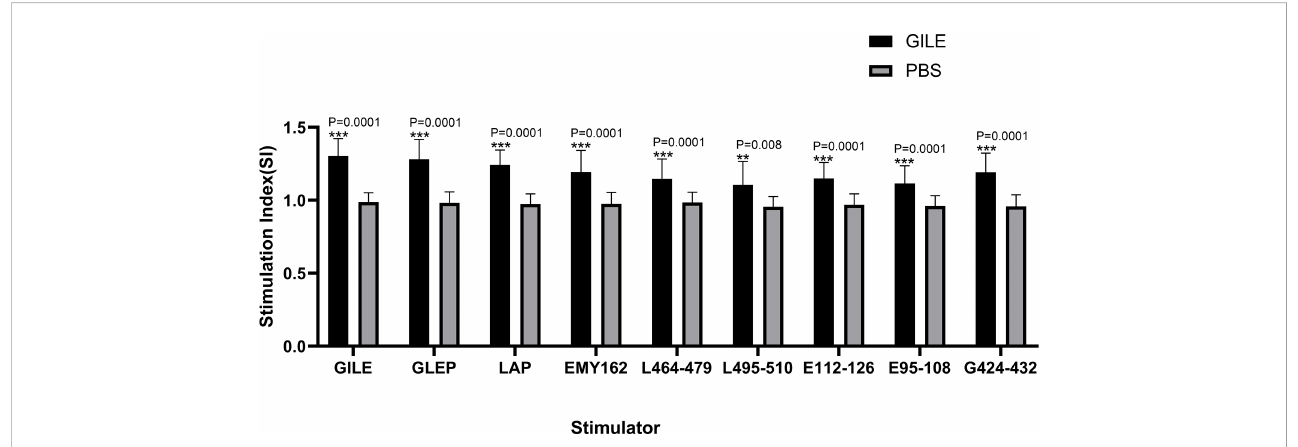
FIGURE 4 Detection of every group ’ s spleen lymphocyte proliferation by MTS the OD was 490nm. **p<0.01,